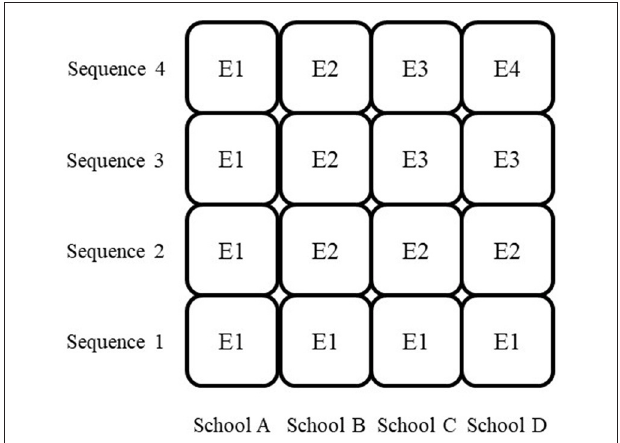
FIGURE 1 | The four schools (A–D), each including two classes, successively implemented an increased level of explicitness of assessment criteria (E1–E4, E4 being the highest level) during four teaching sequences.